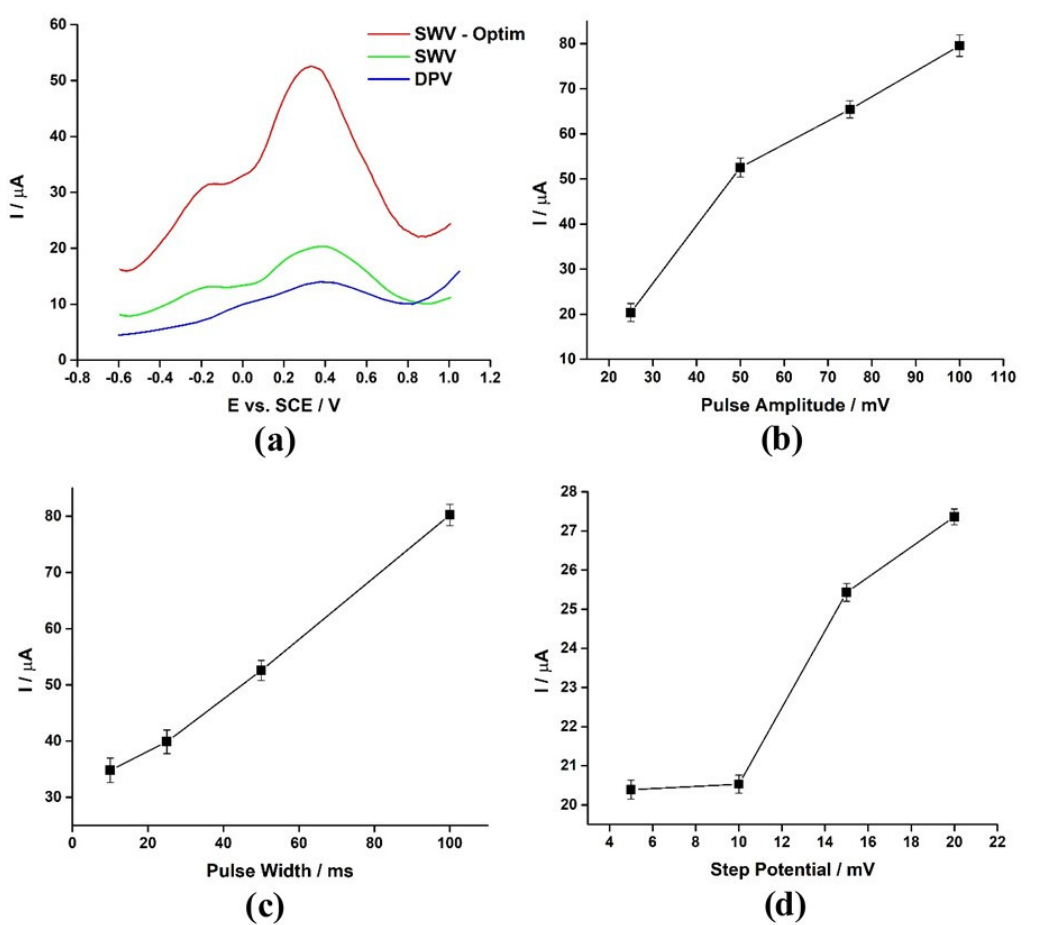
Figure 6. ( a ) Comparison of DPV, SWV, and SWV curves (under optimum conditions) and plots of I vs. ( b ) pulse amplitude, ( c ) pulse width, and ( d ) step potential.